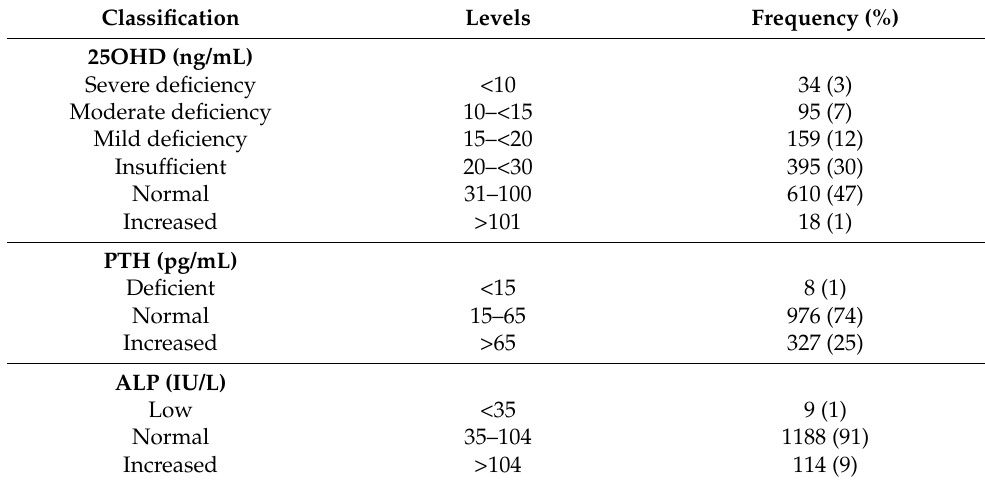
Figure 6. Alkaline phosphates in females over 50. Table 2. Frequency and percentage of vitamin D, ALK, and PTH levels (N =